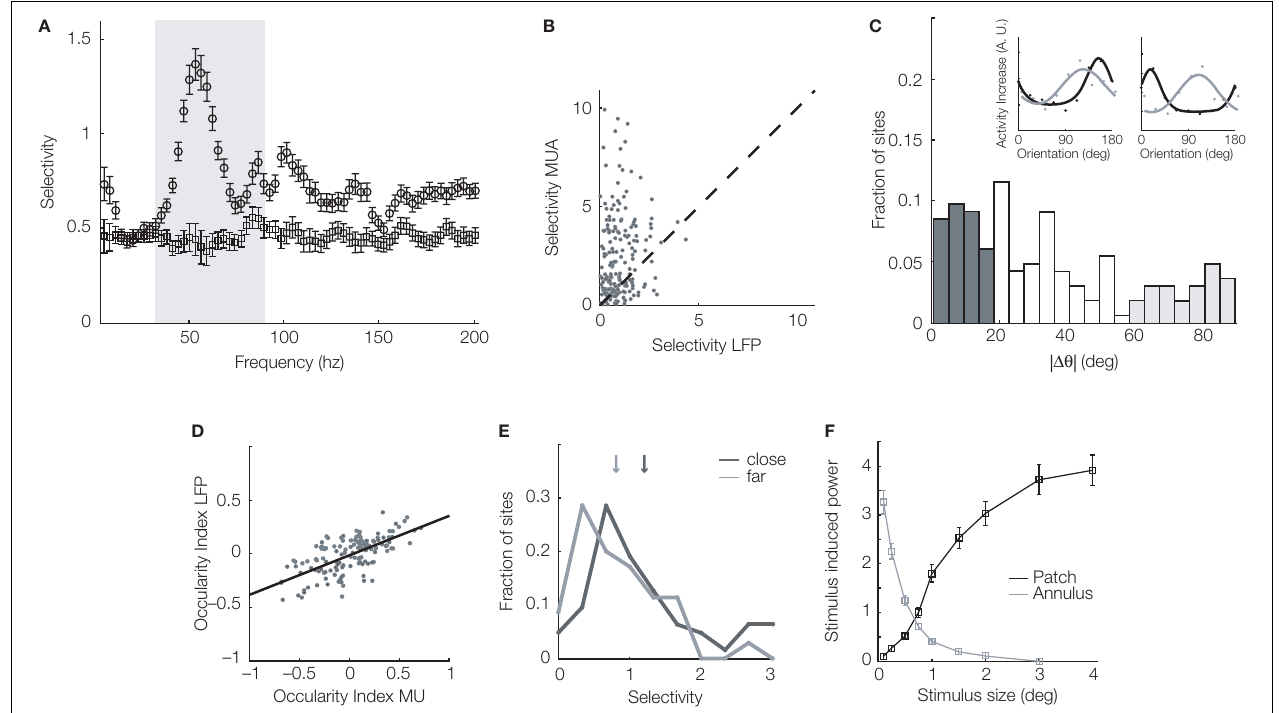
( Figure 3A , grey shaded region).